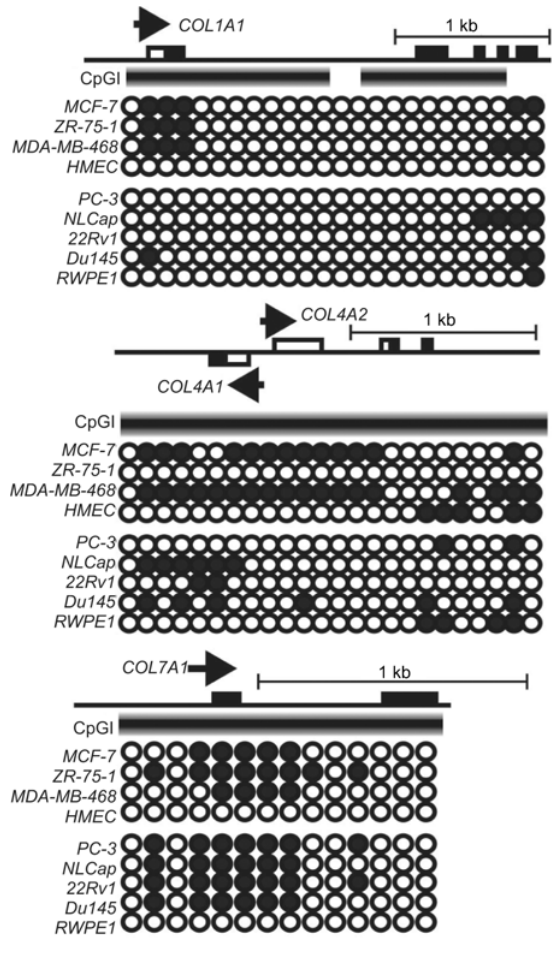
Figure 3 DNA methylation profiling of the COL1A1, COL4A1/ A2 and COL7A1 collagen genes. Each circle represents the methylation data of the individual probe. Open and closed circles represent unmethylated and methylated sites, respectively (68). The arrowhead indicates the transcriptional start site. The thick gradient bar represents CpGI. Open and closed bars correspond to the non-coding and coding regions of the gene, respectively. The cell line abbreviations are shown in the legend of Figure